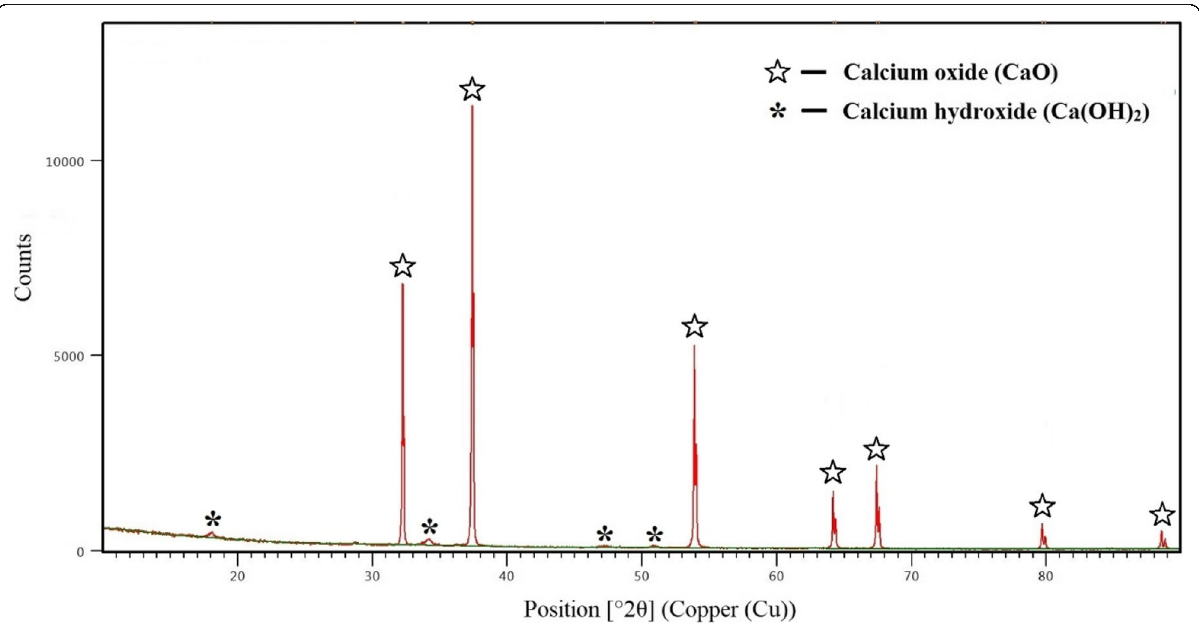
Fig. 2 XRD pattern of calcined